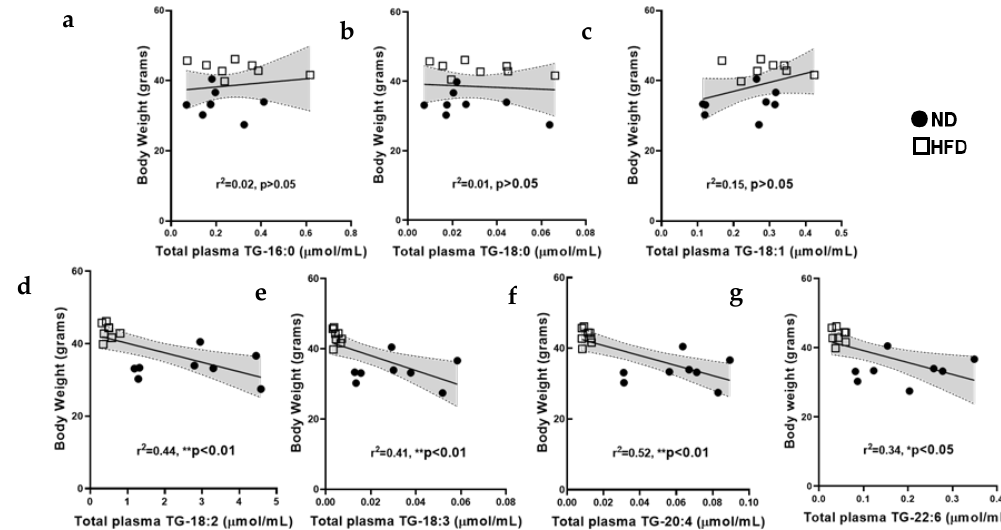
Figure A3. Total levels of plasma ( a ) TG-16:0, ( b ) TG-18:0, ( c ) TG-18:1, ( d ) TG-18:2, ( e ) TG-18:3, ( f ) TG- 20:4 and ( g ) TG-22:6. Data are expressed as means ± SEM, **** p < 0.0001, n.s = not significant. Asterisks indicate significant difference compared to the matched ND value.